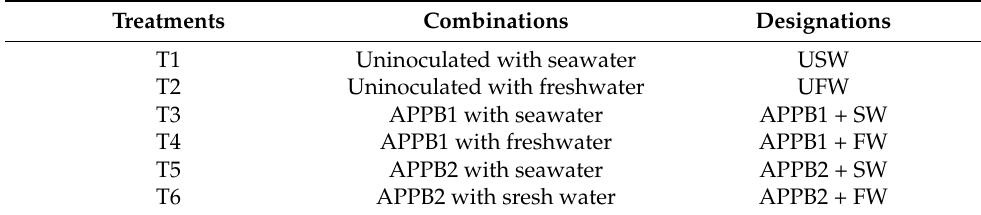
Table 1. List of retting treatments used in augmented kenaf